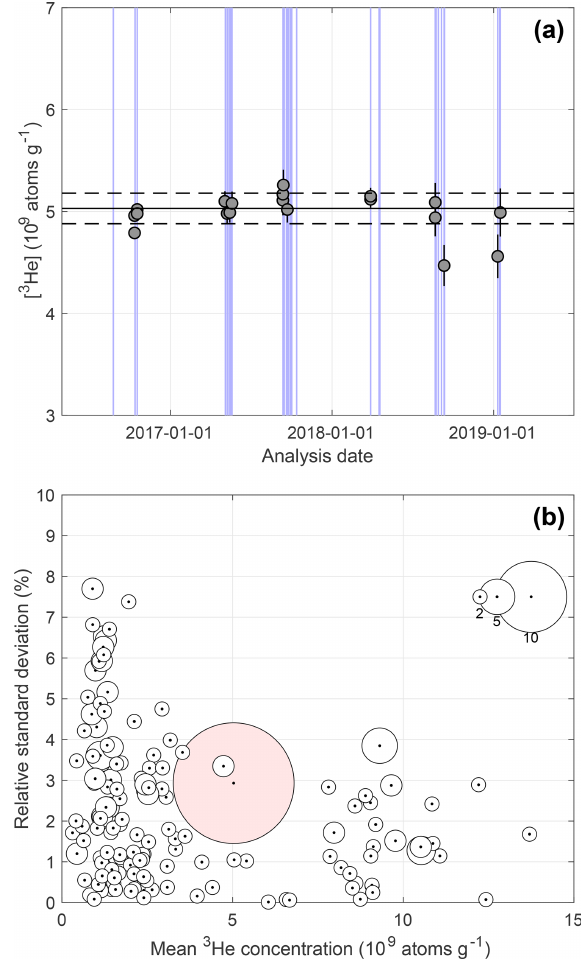
Figure 2. Quality-control data for 3 He measurements. (a) Repli- cate analyses of CRONUS-P in all measurement periods during 2016–2019. Blue lines indicate dates samples in this study were analyzed. Error bars show 68% confidence estimates (i.e., 1 σ ); rel- atively large uncertainties and poor reproducibility in the final two measurement periods reflect unusually nonlinear helium sensitivity and relatively large scatter in analyses of gas standards during these periods. Horizontal lines show mean and standard deviation of all measurements. (b) Relative standard deviation of replicate analyses of 142 samples of Ferrar pyroxene analyzed during this study. Of these samples, 21 are not from Roberts Massif and therefore are not reported in this study but are included here for completeness. The size of the symbol indicates the number of times each sample was analyzed. The pink circle is